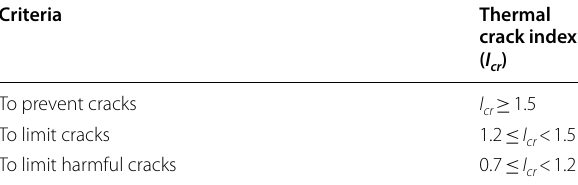
Table 6 Thermal crack criteria.